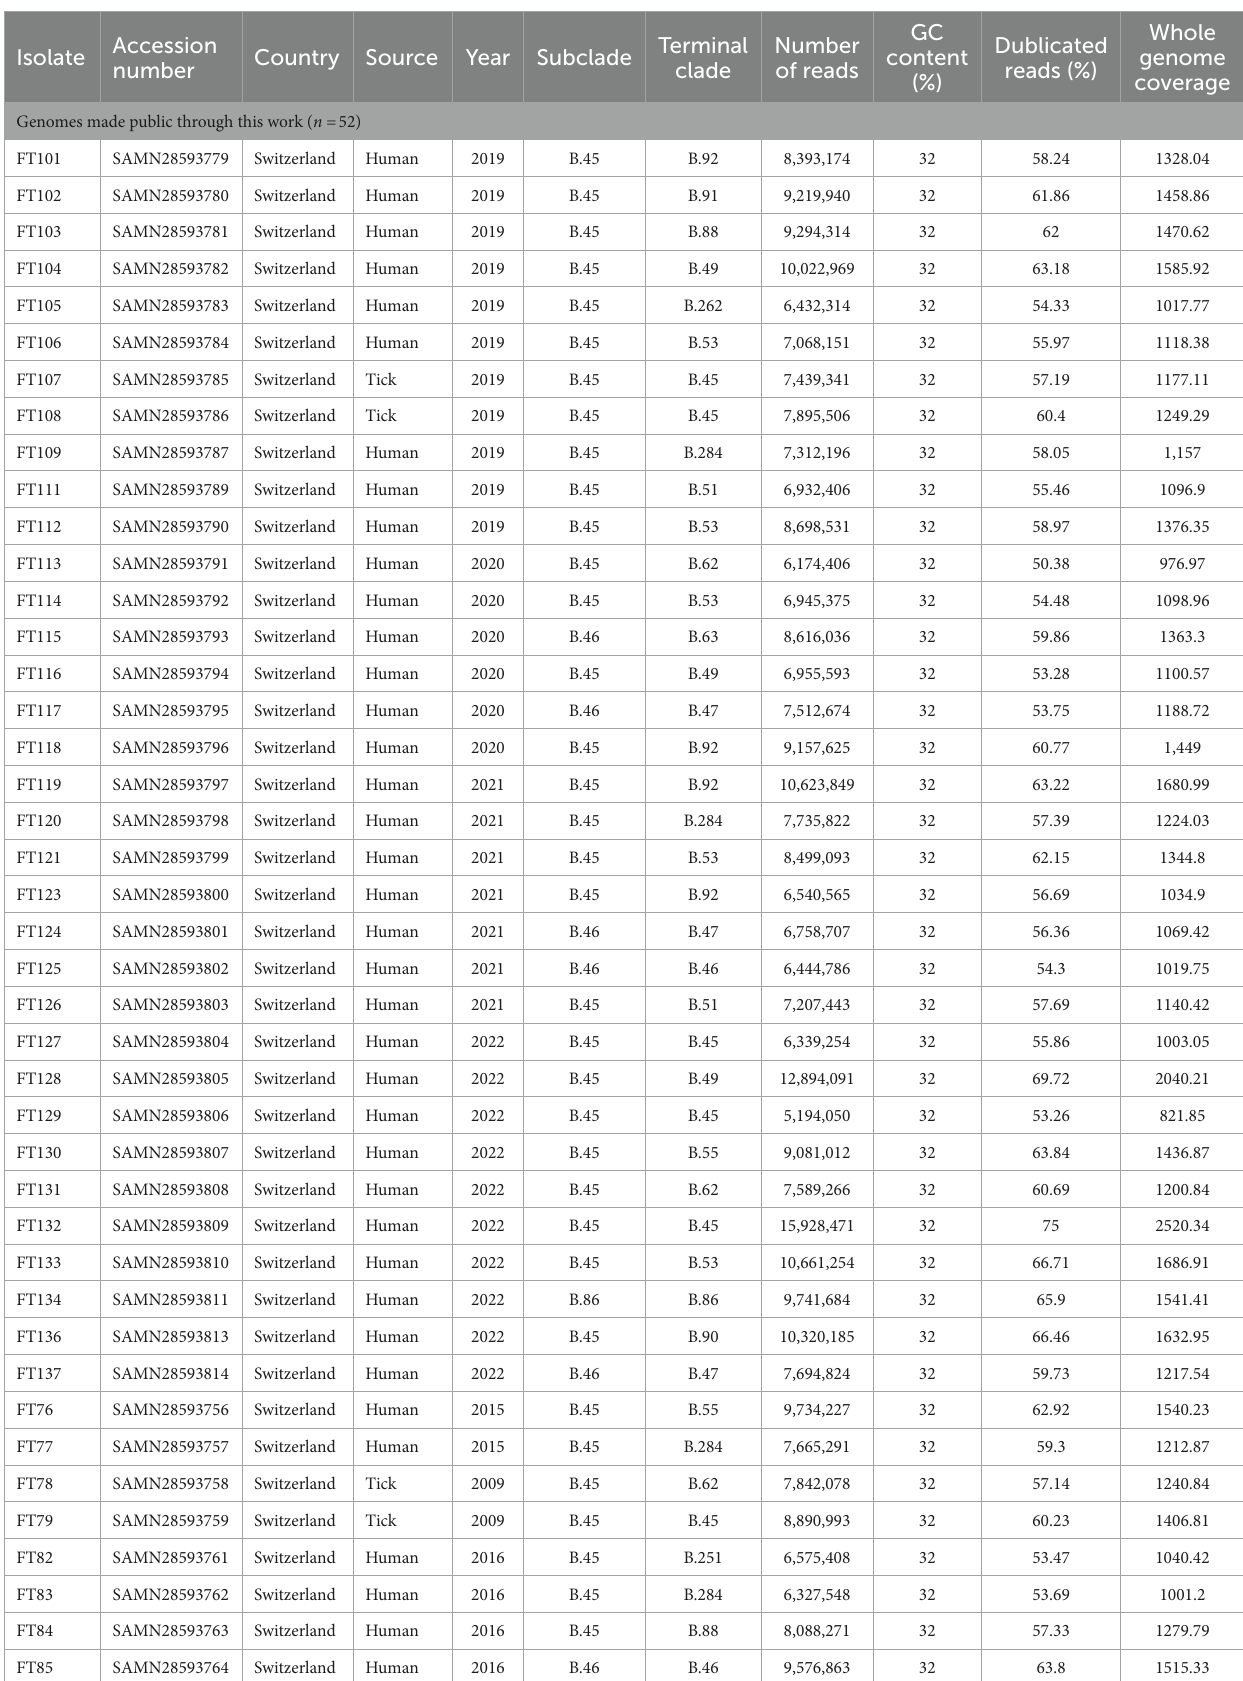
TABLE 1 Overview of the 52 whole-genome sequenced Fth strains from Switzerland used in this study.